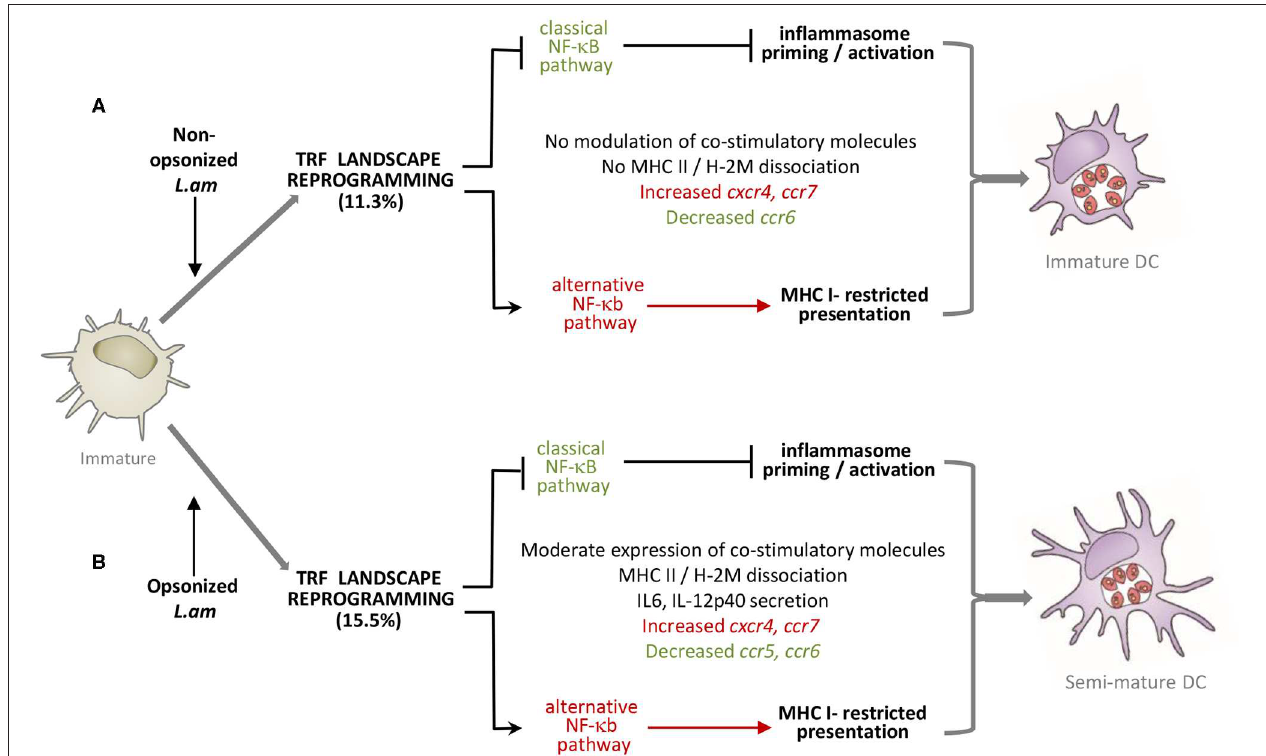
FIGURE 8 | Model of DC subversion by L. am amastigotes. Transcriptomic and phenotypic modulations induced by non-opsonized (A) and Ab-opsonized (B) L. am amastigotes in immature BMDCs are shown. In both cases, inhibition of the classical NF- κ B pathway is linked to prevention of inflammasome priming and activation. The alternative NF- κ B pathway is favored in both infection conditions, likely promoting MHC I-restricted antigen presentation.